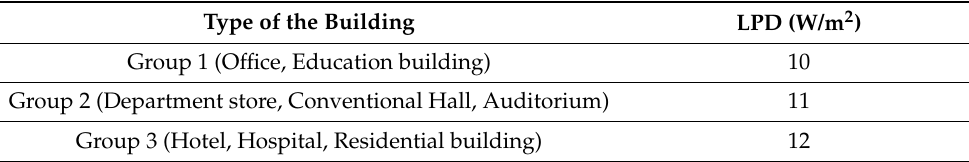
Table 3. Allowance LPD (lighting power density) values in building energy